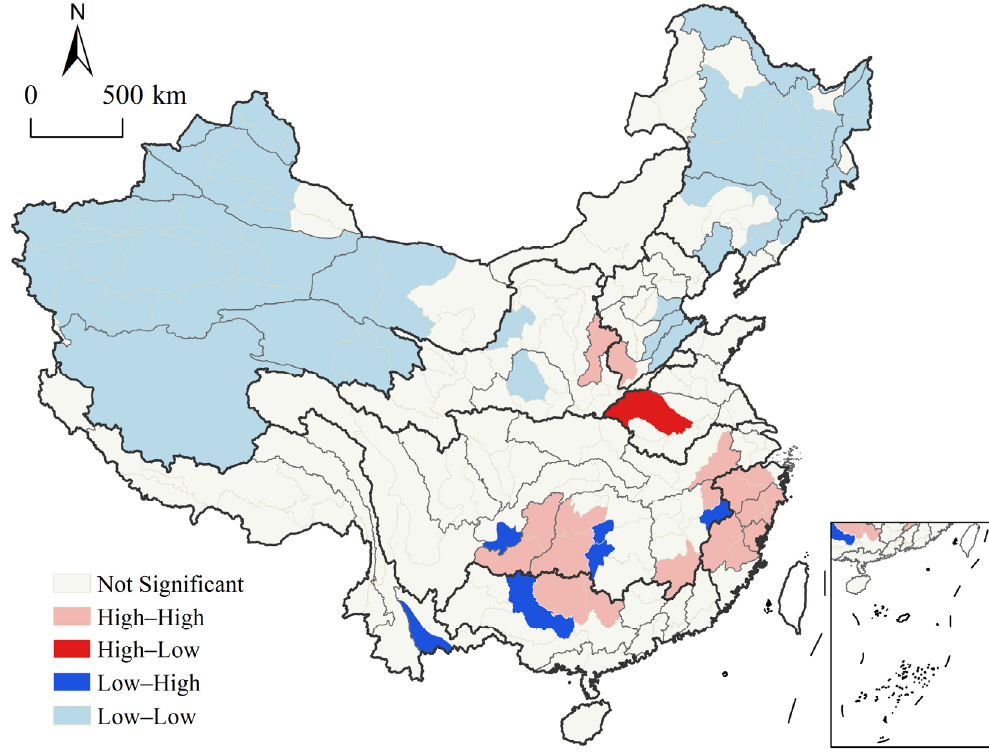
Figure 2. LISA cluster map of traditional villages in China.